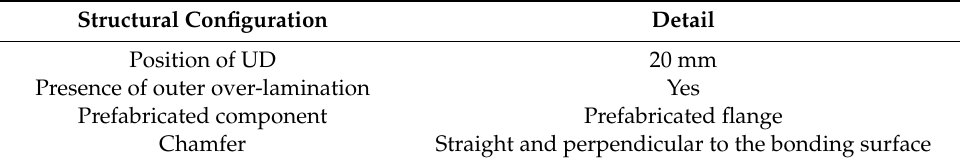
Table 3. Structural configurations of PC model.